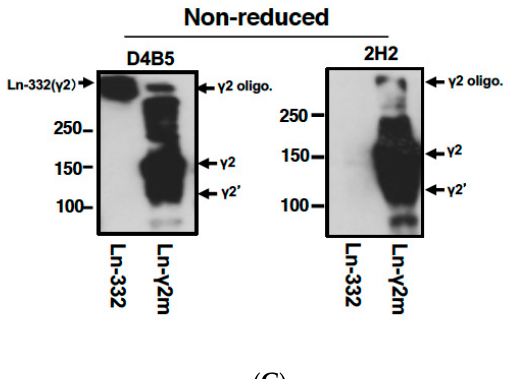
Figure 3. ( A ) The sensorgrams of SPR analysis for interactions between 2H2 mAb and monomeric Ln- γ 2 (left), and 2H2 mAb and Ln-332 (right); 2H2 reacts with monomeric Ln- γ 2 chain but not with the γ 2 chain of Ln-332 trimer. ( B ) Immunoprecipitation (IP) of Ln- γ 2 chain by 1H3 and 2H2 mAbs. Purified monomeric Ln- γ 2 or Ln-332 (0.5 µ g) protein was incubated with mouse immunoglobulin (IgG), 1H3 mAb, or 2H2 mAb (2 µ g/mL each). Antibody-antigen complexes were then precipitated and subjected to western blotting (WB) using anti-Ln- γ 2 polyclonal antibody (pAb). In addition to the intact form of Ln- γ 2 (140 kDa), NH 2 -terminal (70 kDa) and COOH-terminal (100 kDa) fragments, processed by MMP-14 or mTLDs (Figure 1, right ② ), are detected and indicated as γ 2, DIII/IV, and γ 2’, respectively. Left, sample proteins (monomeric Ln- γ 2 and Ln-332) used for the assay were directly analyzed by WB using anti-Ln- γ 2 pAb. Figure 3B is from Koshikawa et al. [30]. ( C ) Use of 2H2 and D4B5 mAbs in WB analysis. D4B5 is a commercially available anti-Ln- γ 2 mAb. Purified monomeric Ln- γ 2 (1 μ g) and Ln-332 trimer (3 μ g) proteins were separated by 7.5% SDS-PAGE and blotted on PVDF membranes under non-reducing conditions, and then detected either by D4B5 or 2H2 mAb. Arrows, Ln- γ 2 homo-oligomer ( γ 2 oligo), monomer ( γ 2), its processed fragment ( γ 2’), and Ln-332.